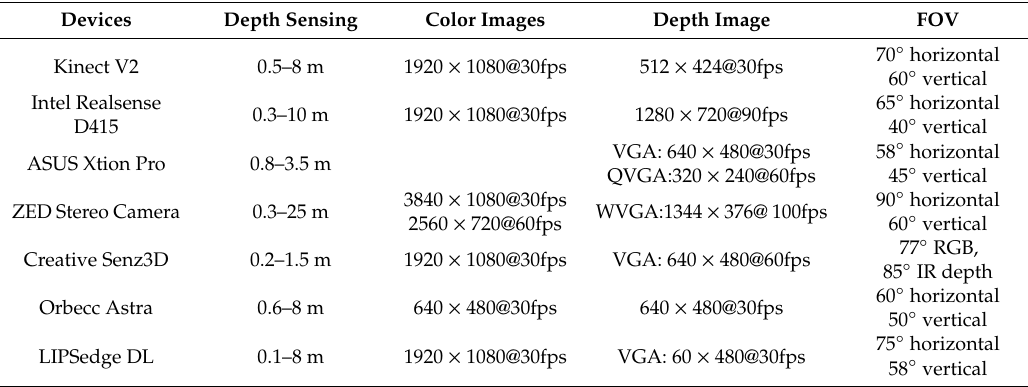
Table 1. Summary of specifications of depth sensor